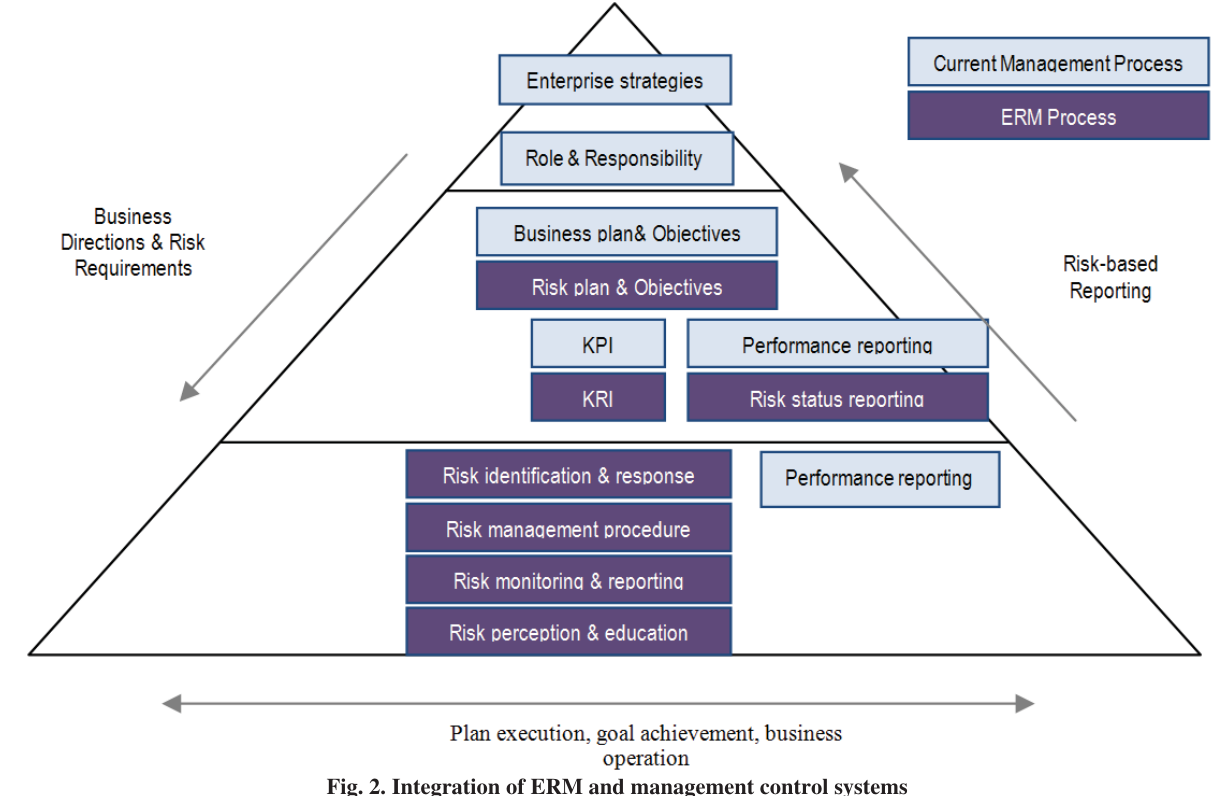
Fig. 2. Integration of ERM and management control systems